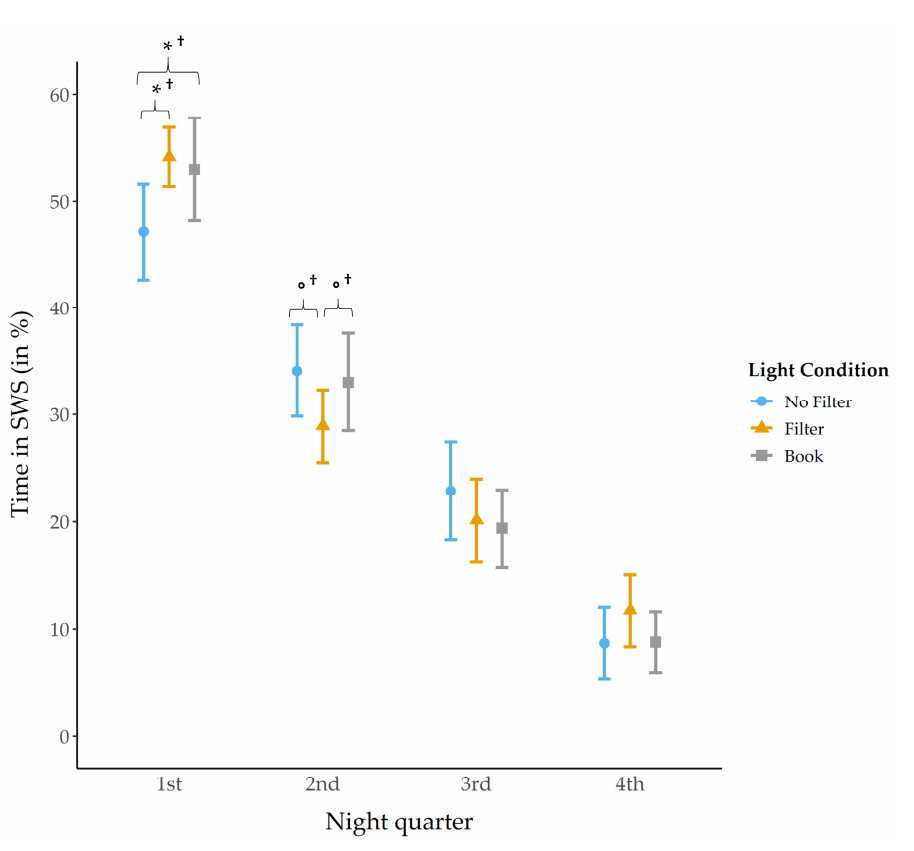
Figure 5. Time in SWS (mean and 95% confidence intervals). The amount of SWS in the first night quarter was significantly reduced in the “no filter” condition as compared to the “filter” and “book” condition. In the second night quarter, the amount of SWS was significantly reduced in the “filter” condition compared to the “no filter” and by trend compared to the “book” condition. *: p ≤ 0.05; ◦ : p < 0.10; †: p adj . >